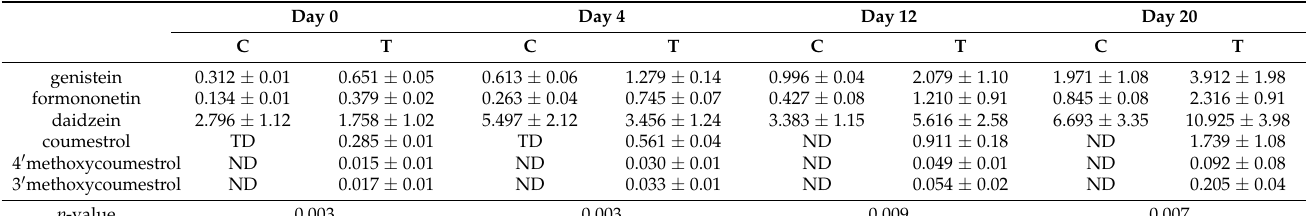
Table 2. The average concentration of the six phytoestrogens (ng · mL − 1 ) in the plasma of the control (C n = 5) and treated (T n = 10) cattle over the 21-day grazing period. Significant differences ( p < 0.05) were observed between the control and treatment groups. p values indicate significant differences among cultivars for each metabolite.